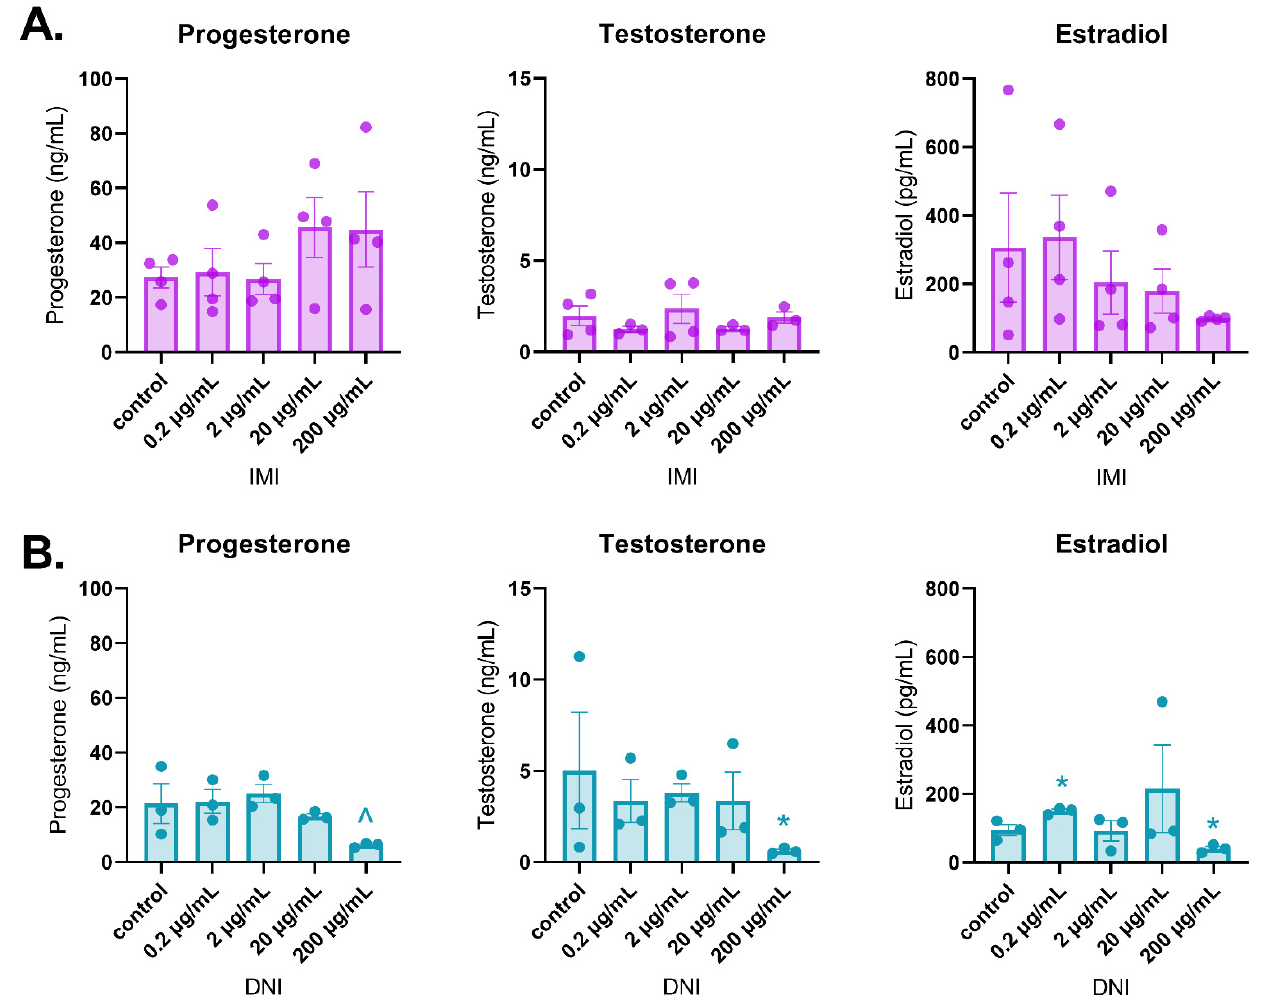
Figure 3. Effects of IMI ( A ) and DNI ( B ) on follicular sex steroid hormone levels after 48 h in culture. Antral follicles were treated with a vehicle (DMSO or water), IMI, or DNI (0.2–200 µ g/mL) for 48 h. After the culture period, media from each treatment were pooled and subjected to ELISAs for testosterone, progesterone, and estradiol. The graphs indicate means ± SEMs from 3–5 separate cultures (8–12 follicles per treatment per culture). * p < 0.05; ^ 0.05 < p < 0.10.